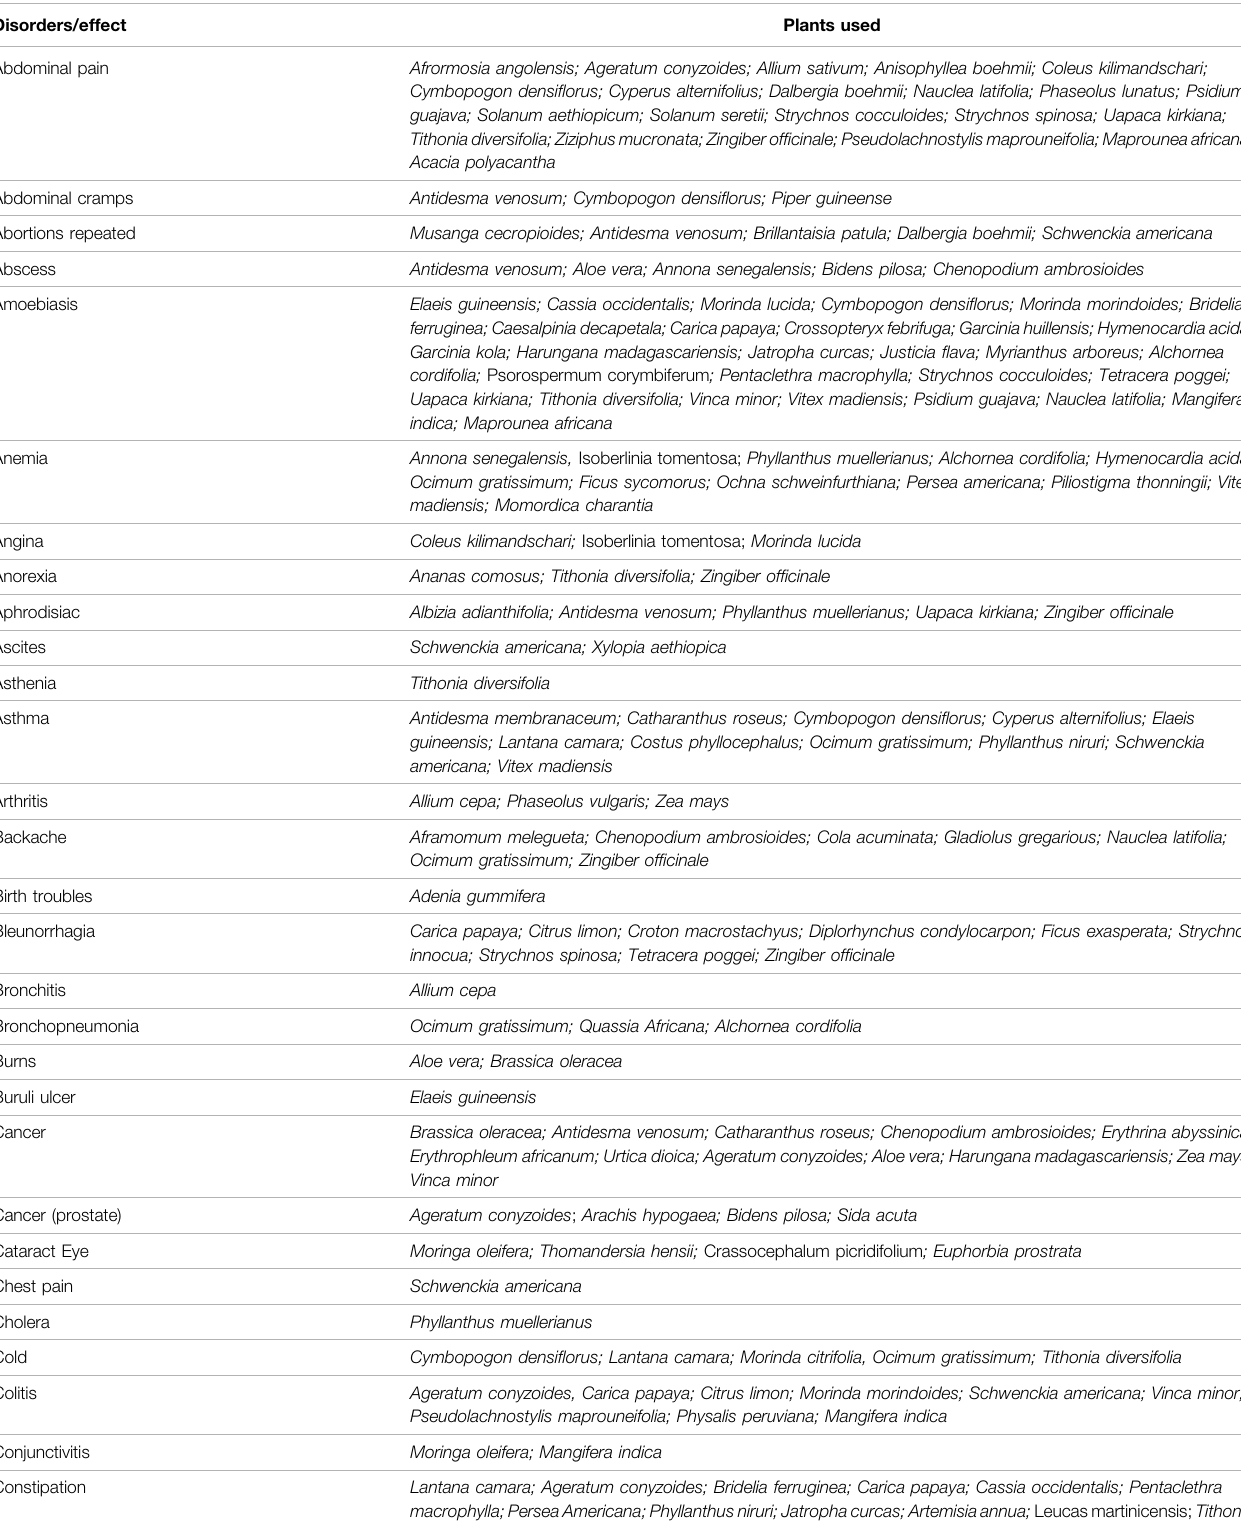
TABLE 3 | Antidiabetic plants used locally for the treatment of other various disorders.